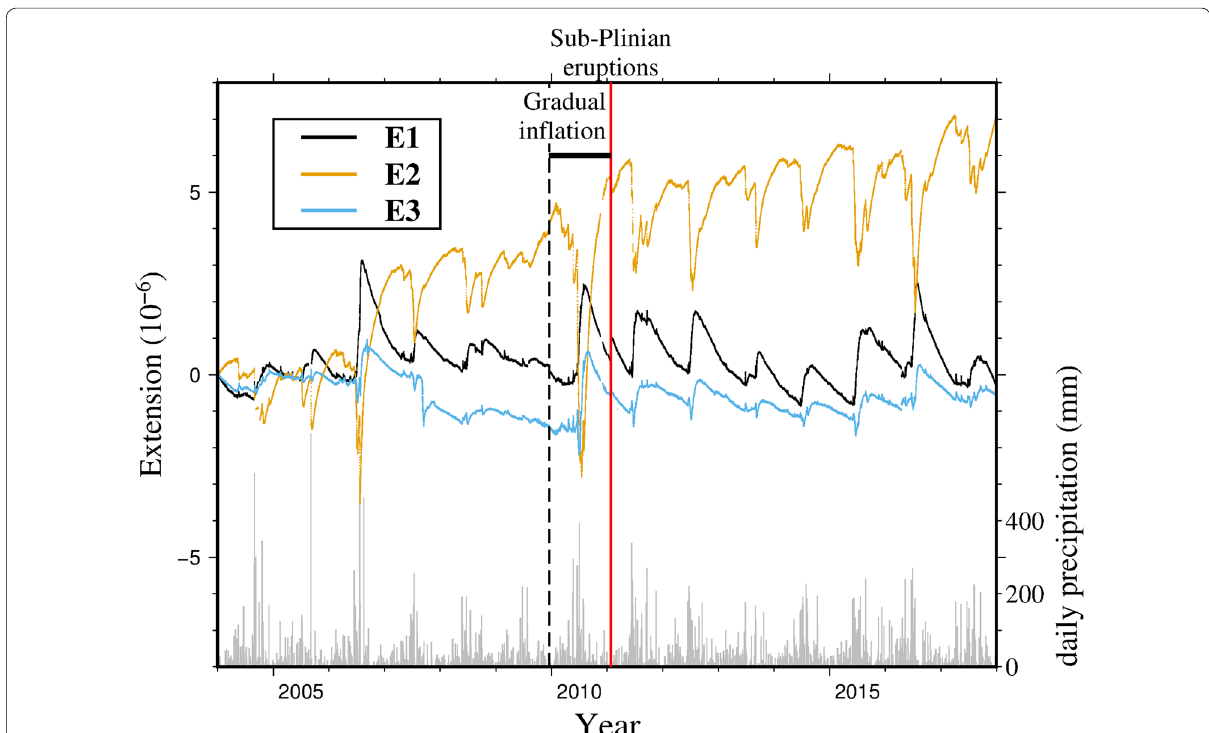
Fig. 2 Strain change along the directions of instruments E1, E2, and E3, from the beginning of 2004 until the end of 2017. Daily precipitation at EBN is also shown (gray bar graph). The vertical red line marks the 2011 sub-Plinian eruptions. The vertical dashed line and thick horizontal bar indicate the onset and duration of the gradual inflation of the edifice, respectively (e.g., Nakao et al.